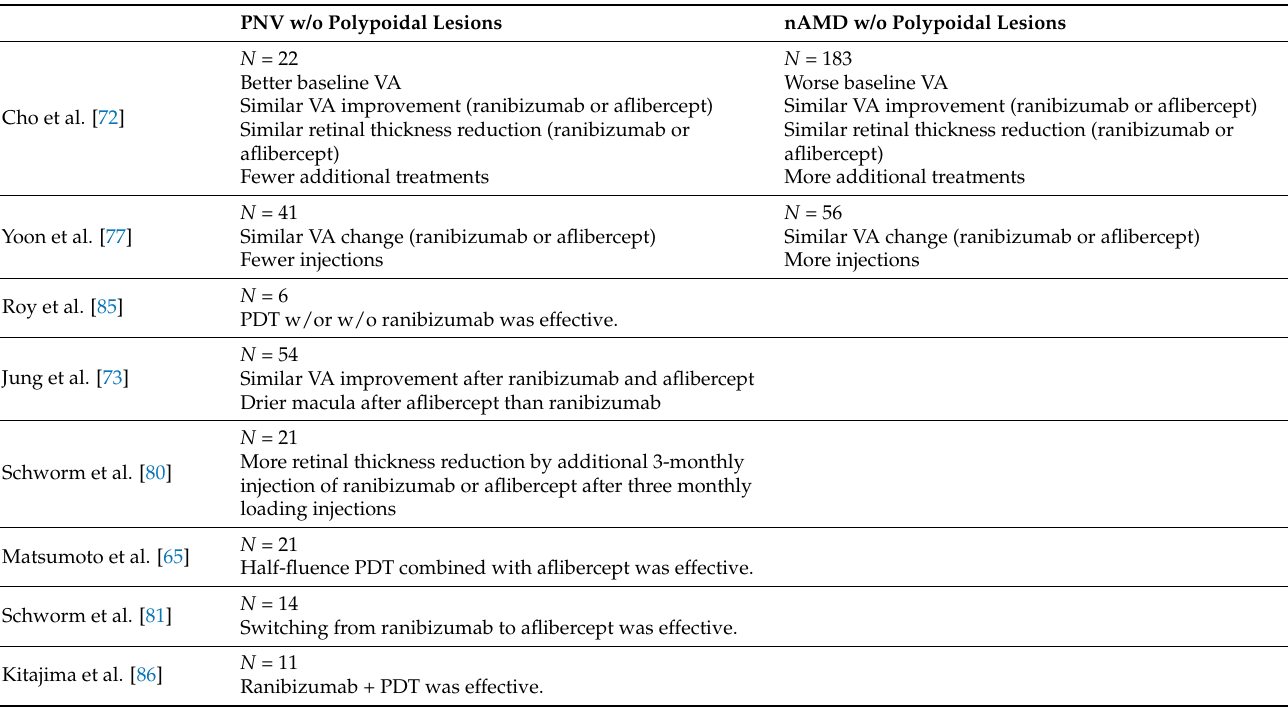
Table 9. Treatment response of PNV without polypoidal lesions and nAMD without polypoidal